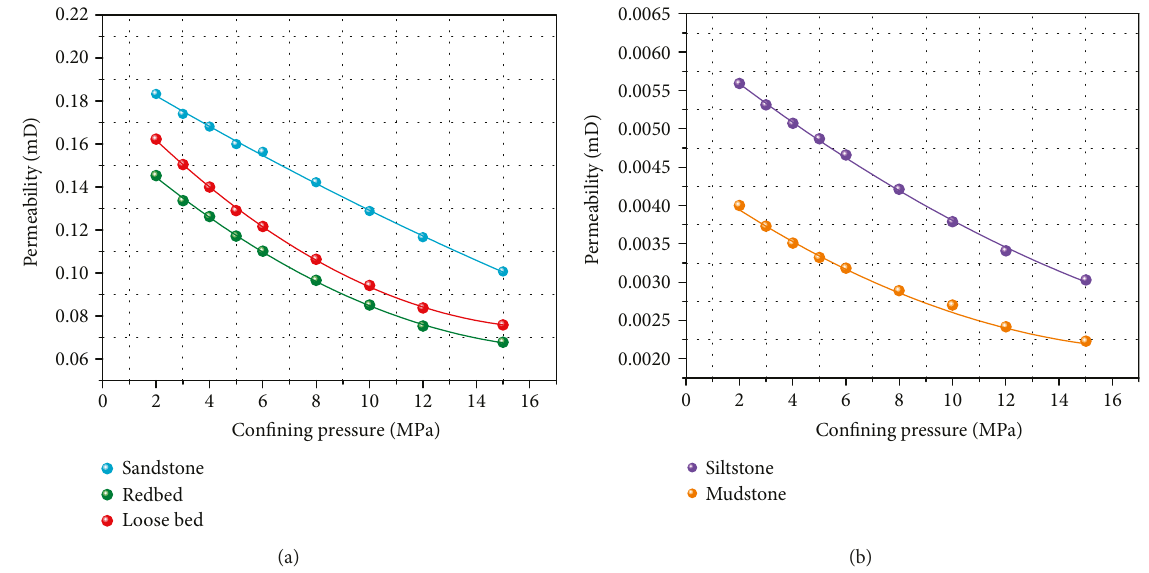
Figure 9: Permeability of cap rock samples under di ff erent con fi ning pressures. Note: loose bed refers to Quaternary and Neogene rocks; Redbed refers to Paleogene rock. Note: the data points were derived from the average values of four surface drilling holes (75-7, 74-7, 74- 11, 67-11, 73-14, and 75-8) that were calculated by the permeability of the coal-bearing rocks (sandstone, mudstone, and siltstone), Paleogene rocks (Redbed), and Neogene and Quaternary rocks (Loose